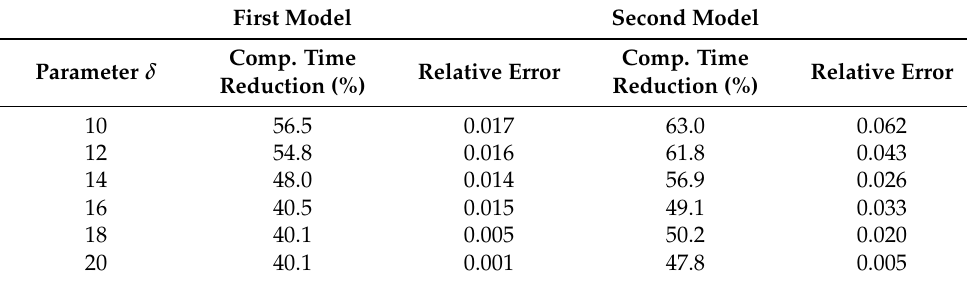
Figure 3. ( a ) Results for the first limestone model. ( b ) Results for the second sediment model. From left to right we see: the map of relevant grid points in the first subinterval, nineteenth subinterval, and thirty-seventh subinterval, and finally, the wavefield corresponding to the end of the thirty-seventh subinterval. The figures were acquired during the simulation, with δ set to 12. The relevant grid points are in the yellow region. The brown line represents the surface of the ocean floor, and the blue line represents the steel object. Table 1. Performance indicators for the first two